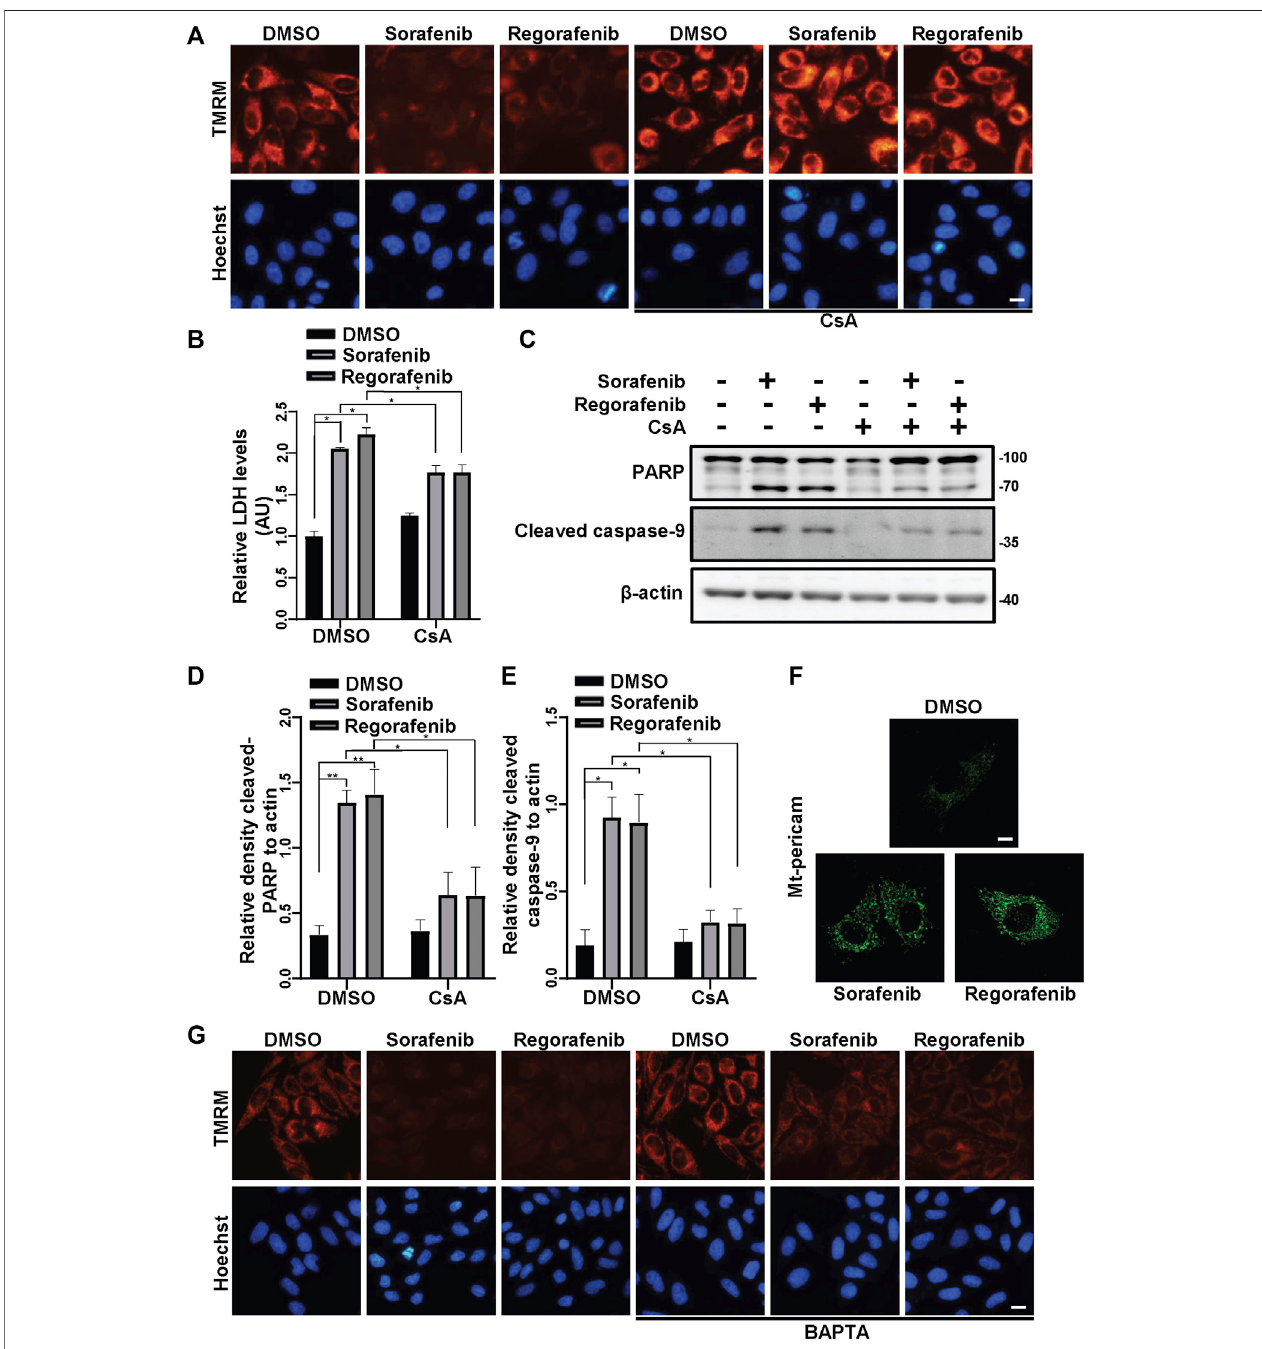
FIGURE 1 | Sorafenib and regorafenib induce mitochondria-related cell death in HepG2 cells due to mtCa 2+ overload-mediated mPTP opening. (A) HepG2 cells were pretreated with CsA (20 μ M) for 1 h and treated with sorafenib (20 μ M) or regorafenib (30 μ M) for 4 h. The cells were then stained with TMRM to show the ΔΨ m. Scalebar,10 μ m. (B) CytotoxicitywasmeasuredusingLDHinHepG2cellspretreatedwithCsA(20 μ M)for1 handtreatedwithsorafenib(20 μ M)orregorafenib(30 μ M) for 24 h. Values are the mean ± SEM from four independent experiments (* p < 0.05, two-way ANOVA and Tukey ’ s multiple comparisons test). (C) Cleaved PARP and cleaved caspase-9 in HepG2 cells that were treated as in B are shown. (D,E) the relative densities of cleaved PARP (D) and cleaved caspase-9 (E) were quanti fi ed, and their protein levels were normalized to the loading control β -actin. Values are the mean ± SEM from three independent experiments (* p < 0.05, ** p < 0.01, two-way ANOVAandTukey ’ smultiplecomparisonstest). (F) HepG2cellsweretransfectedwithmito-pericamandtreatedwithsorafeniborregorafenibfor2 h(scalebar,10 μ m). (G) HepG2cellswerepretreatedwithBAPTA(20 μ M)for1 handtreatedwithsorafenib(20 μ M)orregorafenib(30 μ M)for4 h.ThecellswerethenstainedwithTMRMto show the ΔΨ m. Scale bar, 10 μ